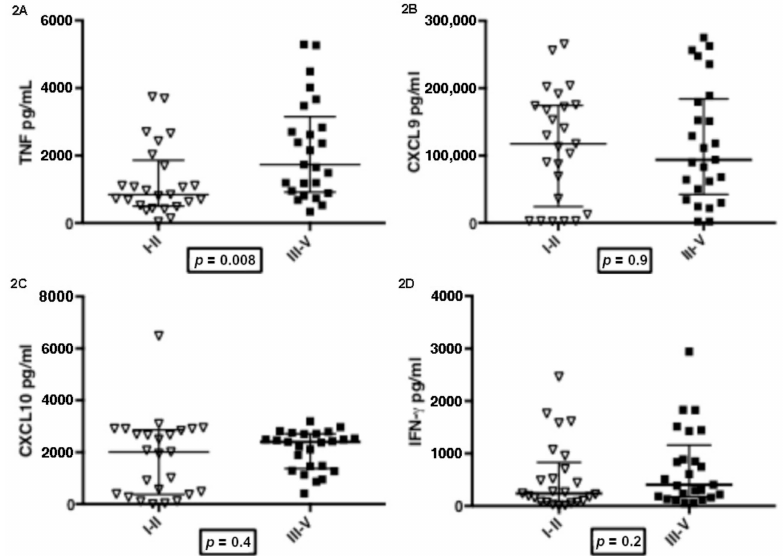
Figure 2. TNF (2A), CXCL9 (2B), CXCL10 (2C), IFN- γ (2D) production and severity of